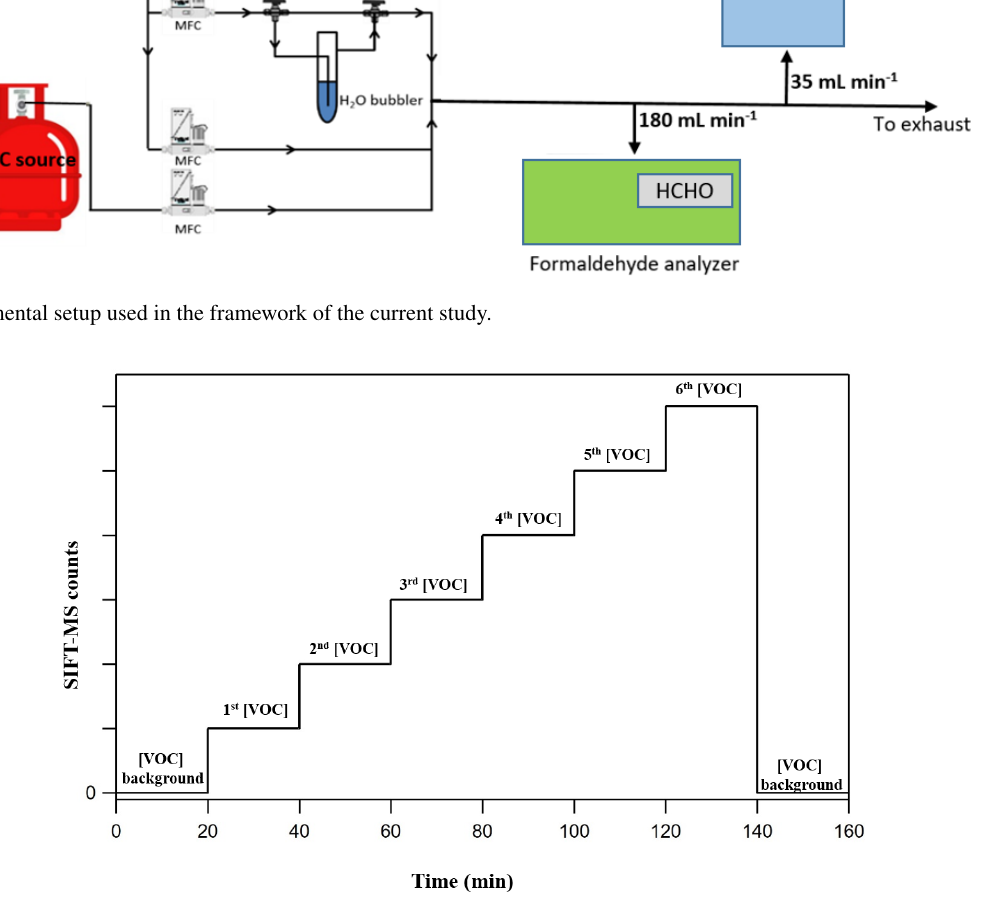
Figure 2. Strategy followed during a typical calibration experiment. At first, the background of the VOC at the corresponding mass peak(s) is recorded. Then its concentration is progressively increased and monitored with SIFT-MS. Typically, four to six different concentrations of the VOC of interest are set before returning to background